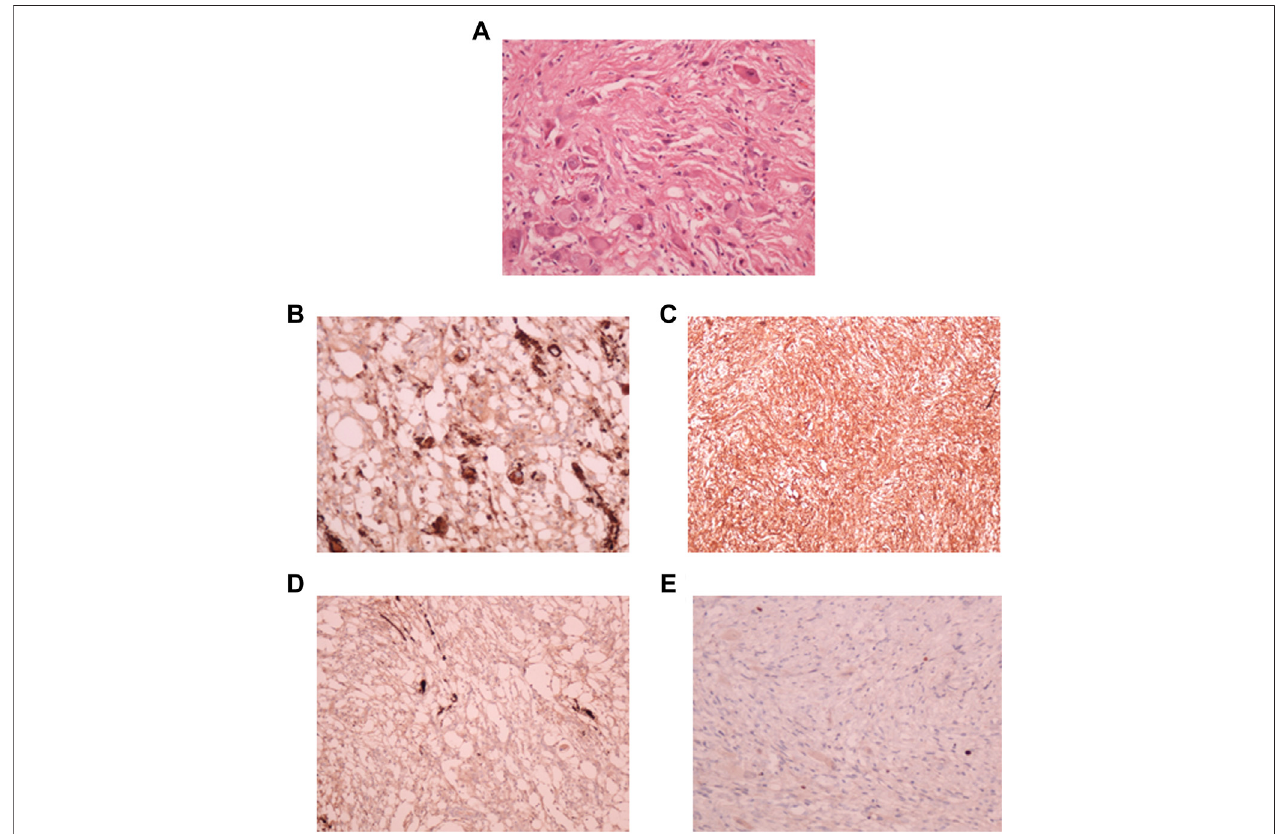
FIGURE 2 | Pathological diagnosis of DIG. (A) : Hematoxylin and Eosin stained tissue section at 40X showing desmoplastic stroma with intervening atypical neuronal cells with enlarged nucleoli. Immuno-histochemical staining showed strong positivity for synaptophysin (B) , Vimentin (C) , focal positivity for GFAP (D) , and a lack of staining for MIB-1 index (E) .